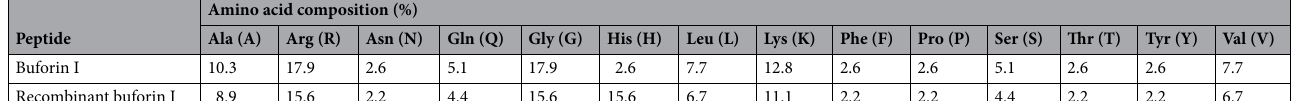
Amino acid composition